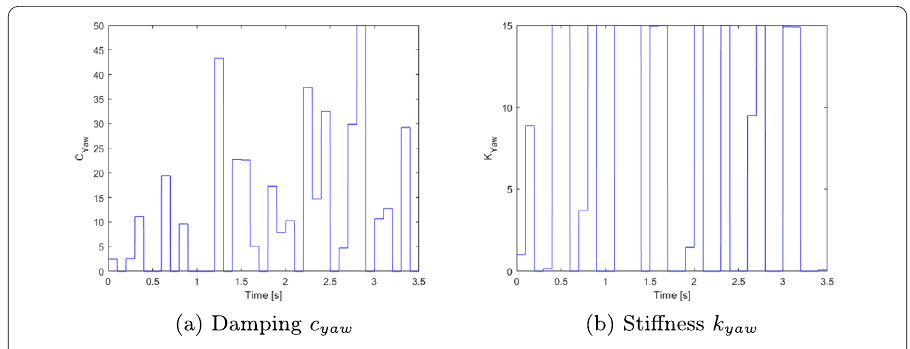
Figure 11 Damping and stiffness for the yaw axis